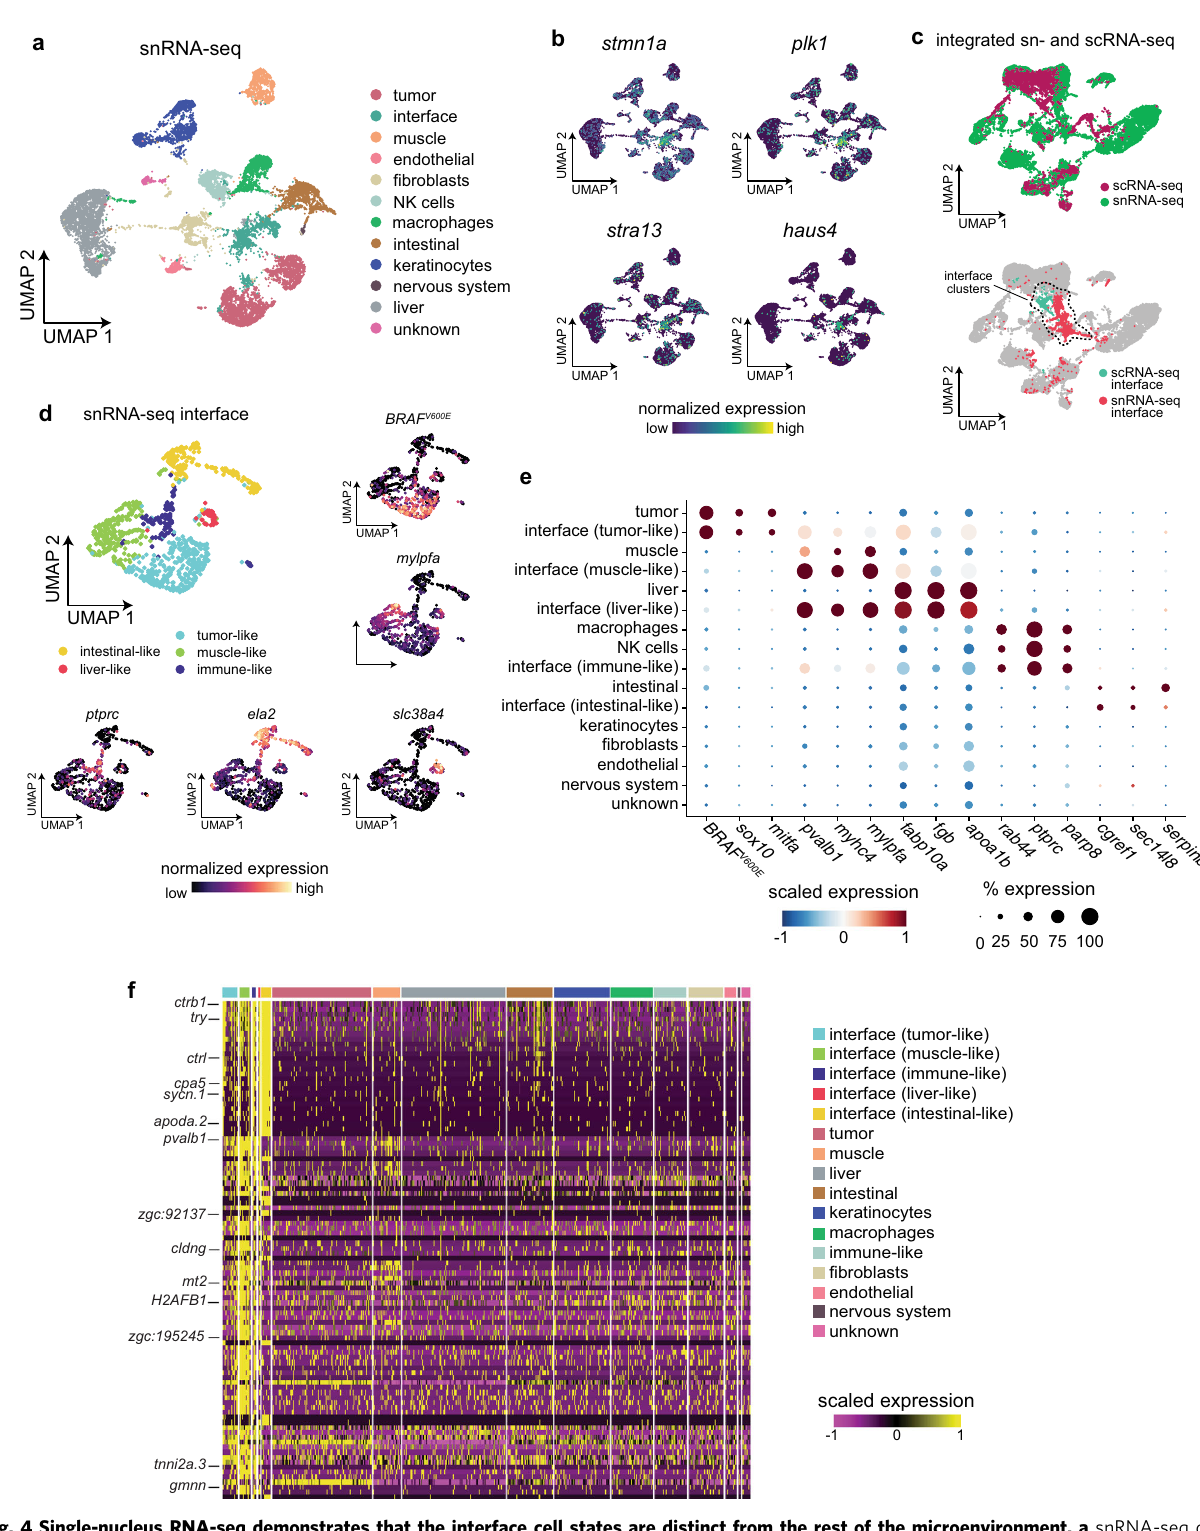
Fig. 4 Single-nucleus RNA-seq demonstrates that the interface cell states are distinct from the rest of the microenvironment. a snRNA-seq cluster assignments plotted in UMAP space. b Expression of marker genes from the scRNA-seq interface cluster in the snRNA-seq dataset. c Integrated UMAP of the snRNA-seq and scRNA-seq datasets (labeled, top plot) showing colocalization of the two interface clusters (bottom plot). d Subcluster assignments and expression of marker genes from the snRNA-seq interface cluster. e Dotplot showing expression of microenvironment cell-type speci fi c genes within the interface subclusters. f Heatmap showing expression of the top 100 genes upregulated across all of the interface